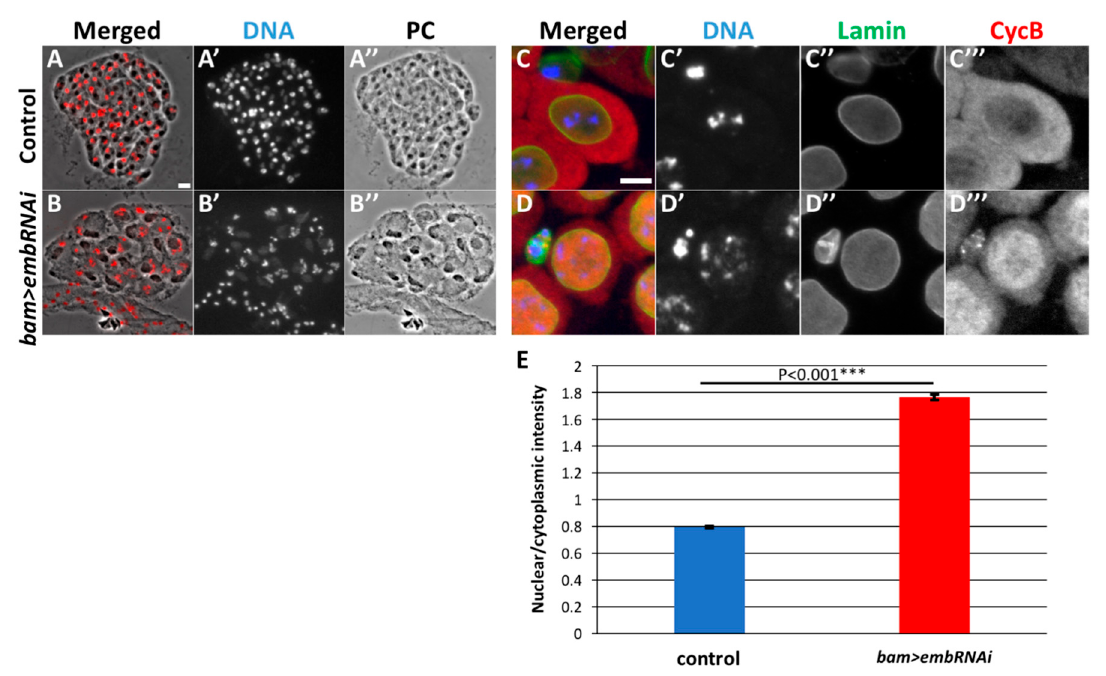
Figure 6. Depletion of emb resulted in meiotic cell cycle defect and abnormal CycB distribution, as observed in testes depleted of the Nup62 complex. ( A , B ) Phase contrast and fluorescence micrographs of an intact cyst consisting of spermatids at the onion stage and slightly later stage. Fluorescence of DAPI staining is in red ( A , B ) and white ( A’ , B’ ). PC; Phase contrast micrograph ( A” , B” ). ( A ) A complete cyst consisted of 64 spermatids in a control testis ( bam > dcr2 ). ( B ) A complete cyst consisted of 16 spermatids in emb -depleted testis. Each of the cells possesses a single larger nucleus containing three sets of condensed chromosomes and Nebenkerns. ( C , D ) Immunostaining of premeiotic spermatocytes at later stage of growth phase with anti-CycB (red in ( C , D ), white in ( C” , D” )) and anti-Lamin Dm0 (green in ( C , D ), white in ( C’” , D”’ )) antibodies. DAPI staining, blue in ( C , D ), white in ( C’ , D’ ). ( C )